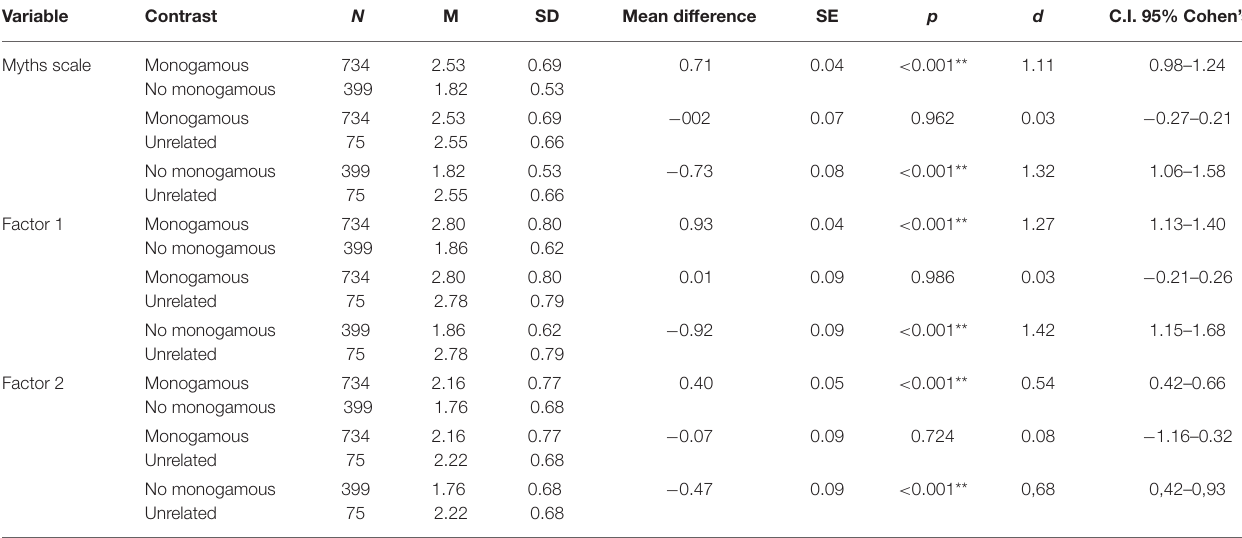
TABLE 6 | Post-hoc factorial ANOVA analysis for the dependent variable of global romantic love myths score and its two factors, considering the type of relationship as a grouping variable. Variable Contrast